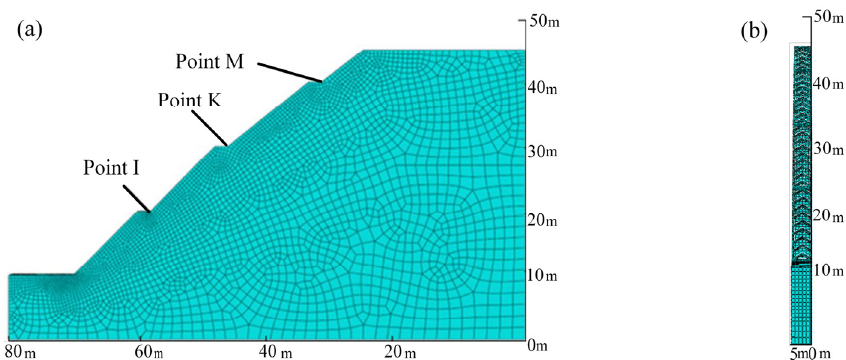
Figure 7. Numerical model of the studied slope: ( a ) lateral view; ( b ) front view.